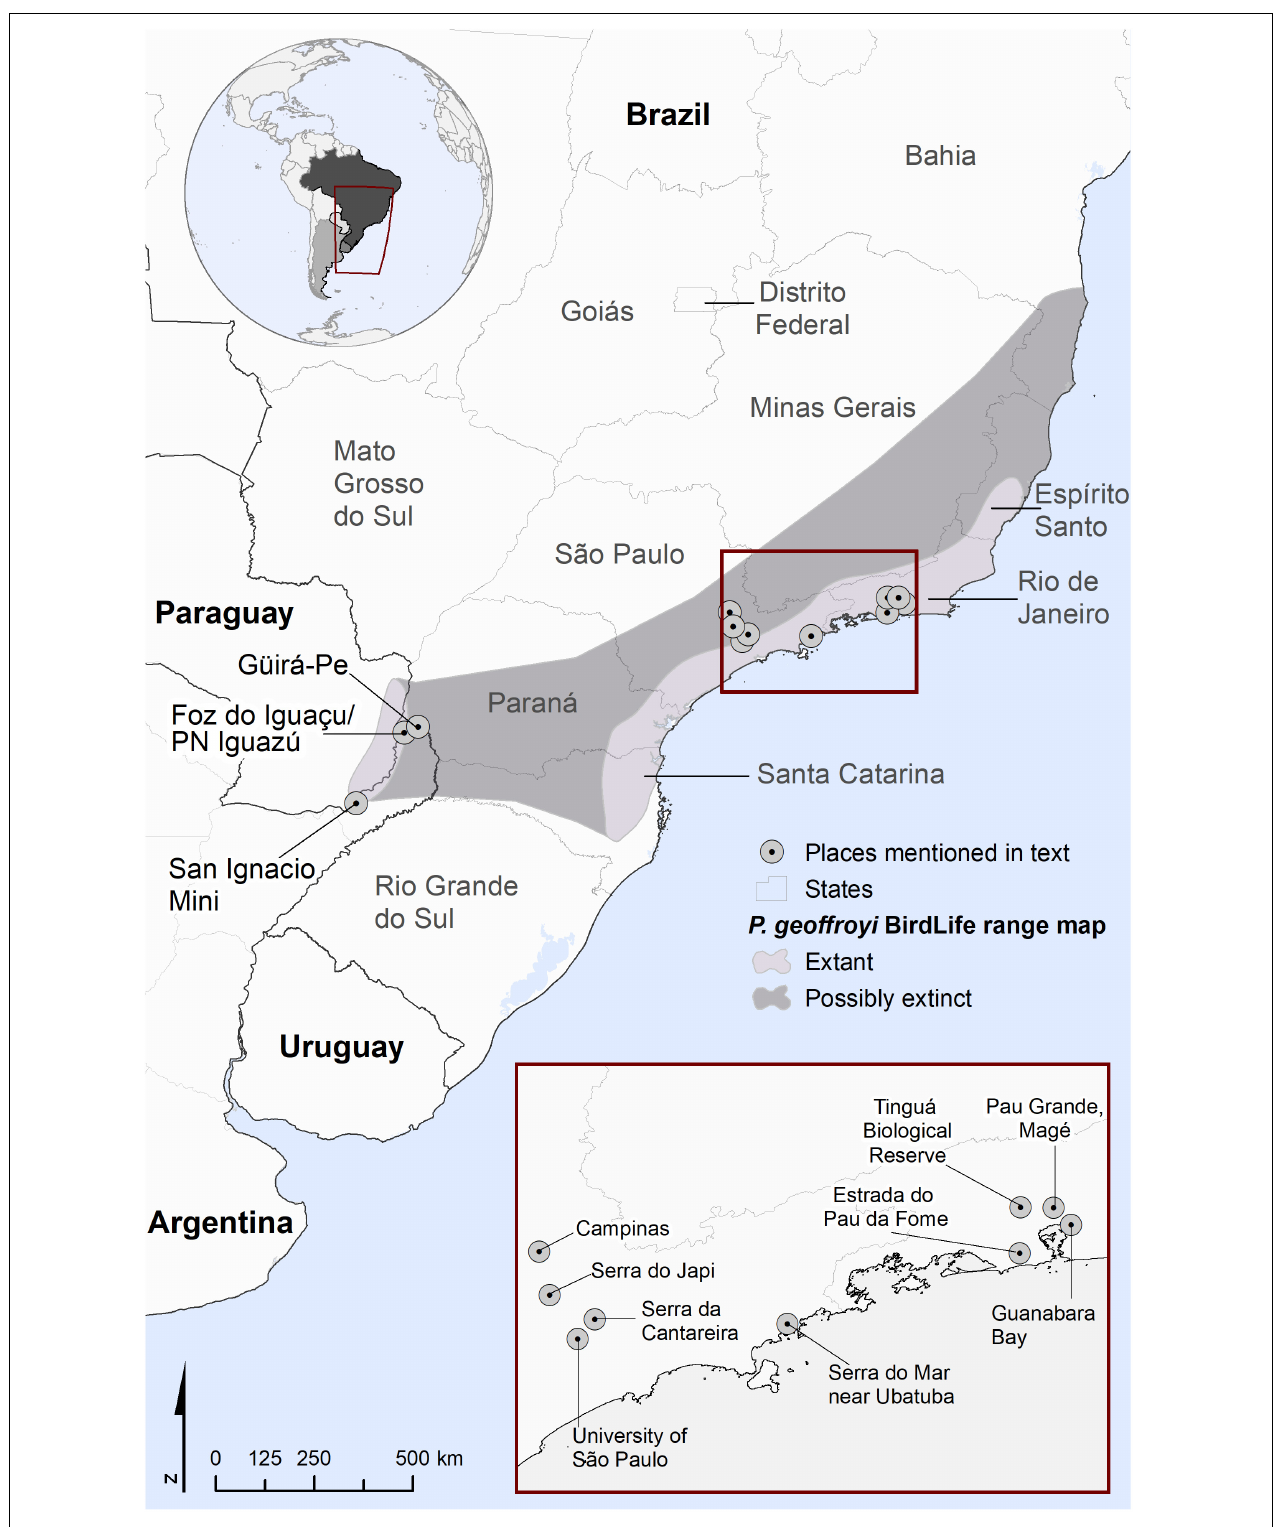
FIGURE 1 | Distribution of Purple-winged Ground Dove according to the current range map by BirdLife International, 2021 as well as places mentioned in text, including sites of specimen records.